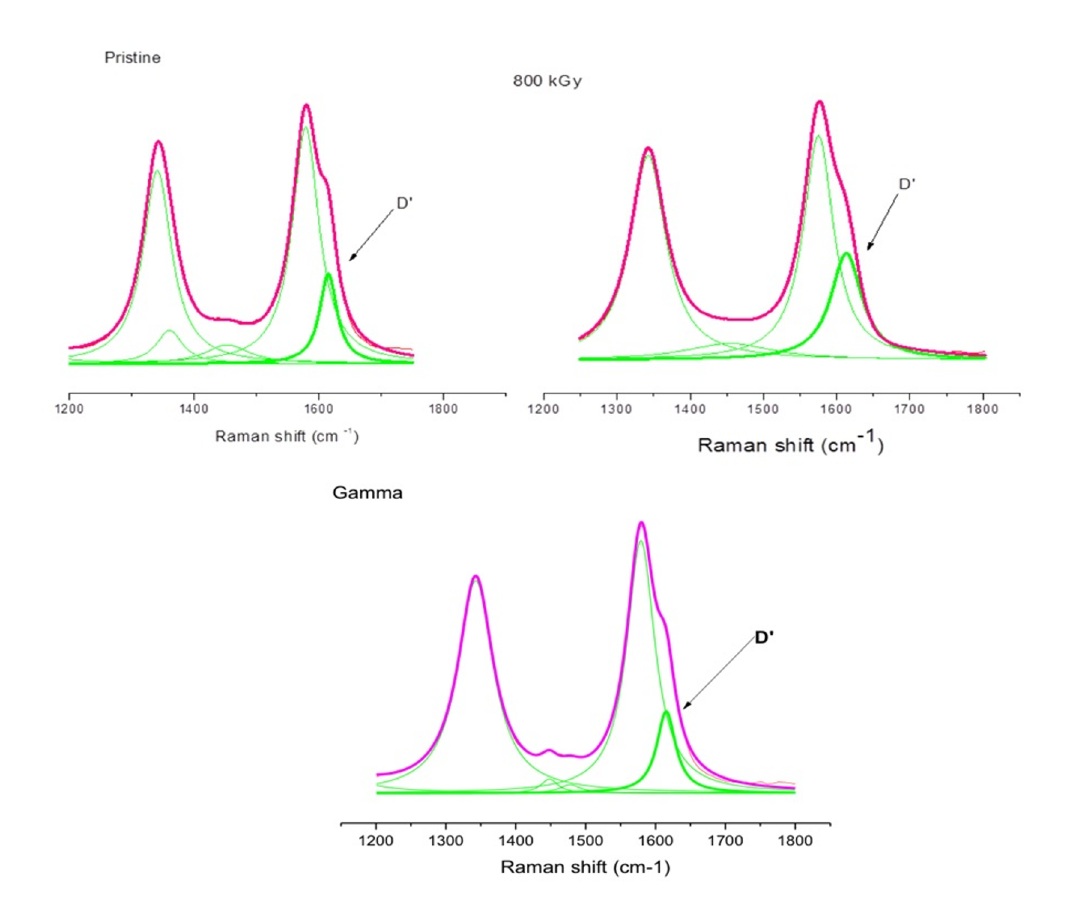
Figure 8. Raman spectra of CNTY from 1200 to 1800 cm -1 - D, G and D´peaks. of CNTs to self repair, the carbon atoms displaced